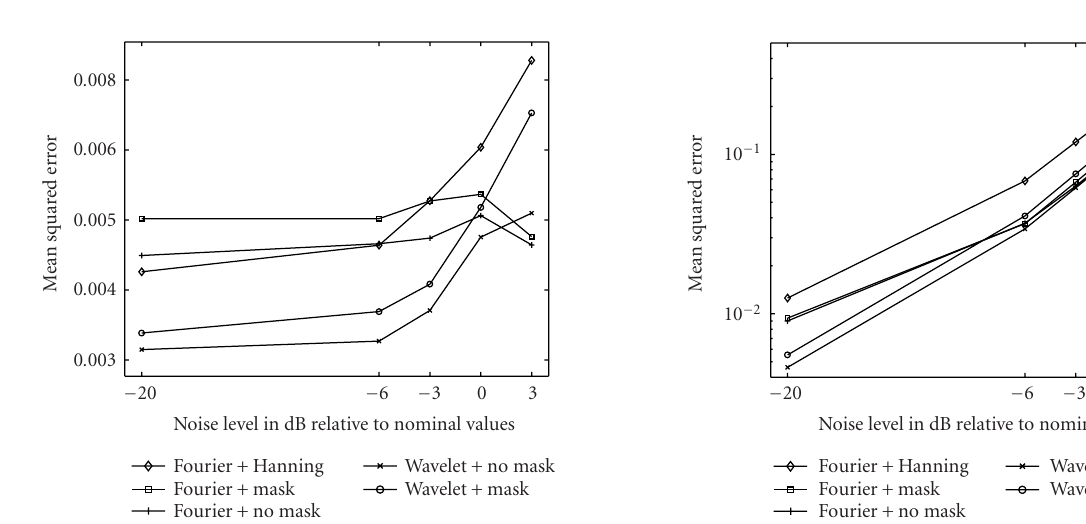
Figure 7: Comparison of the mean squared errors on the estima- tion of the emission law of CMB as a function of noise in five dif- ferent configurations: wSMICA without mask, wSMICA with mask, fSMICA without mask, and fSMICA with mask, and fSMICA with Hanning apodizing window.